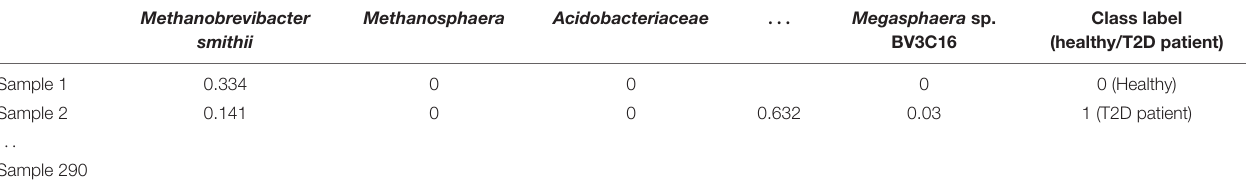
TABLE 1 | The metagenomics dataset of T2D, after the initial preprocessing of the original metagenomics data.